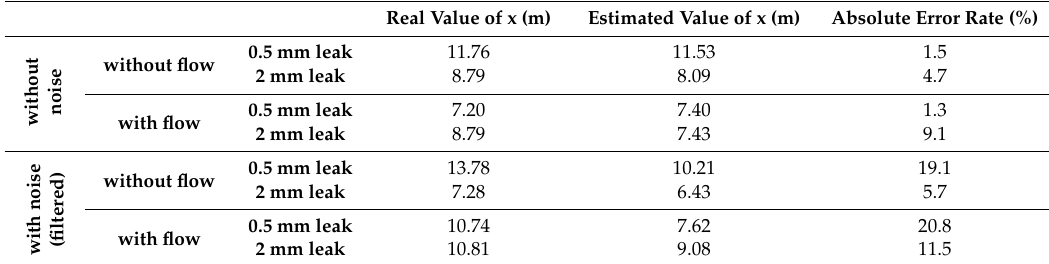
Table 7. Results from the Roth method for 15 m distance between the sensors.